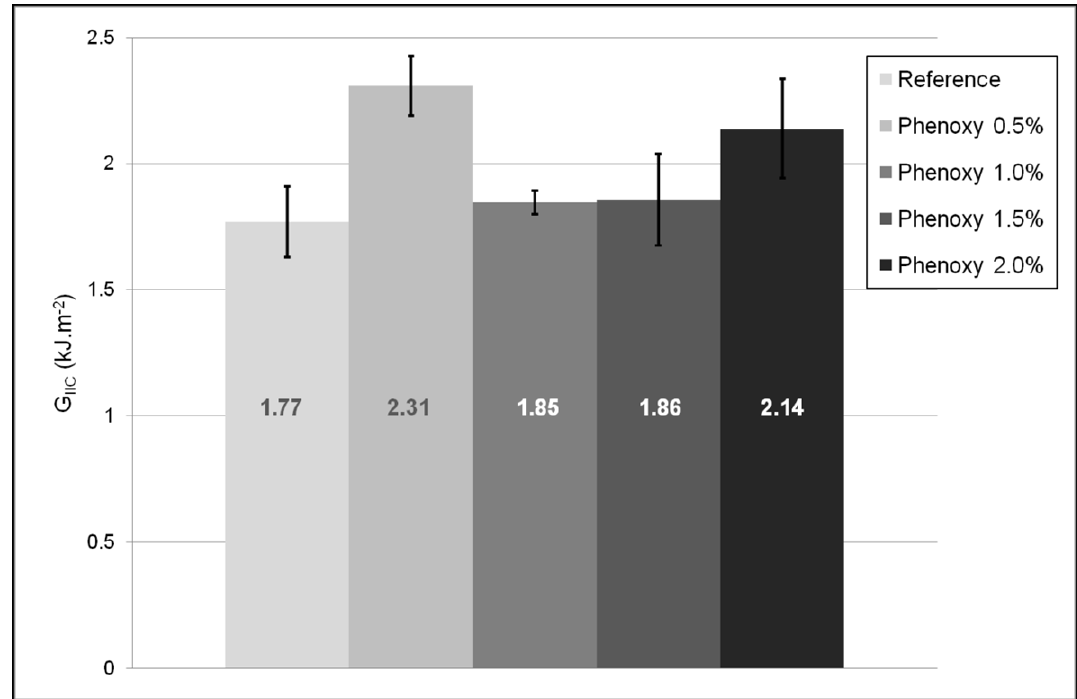
Figure 7. End notch fracture toughness (G sample reinforced with 2 wt % phenoxy nanofibres in each interlayer region of the composite.